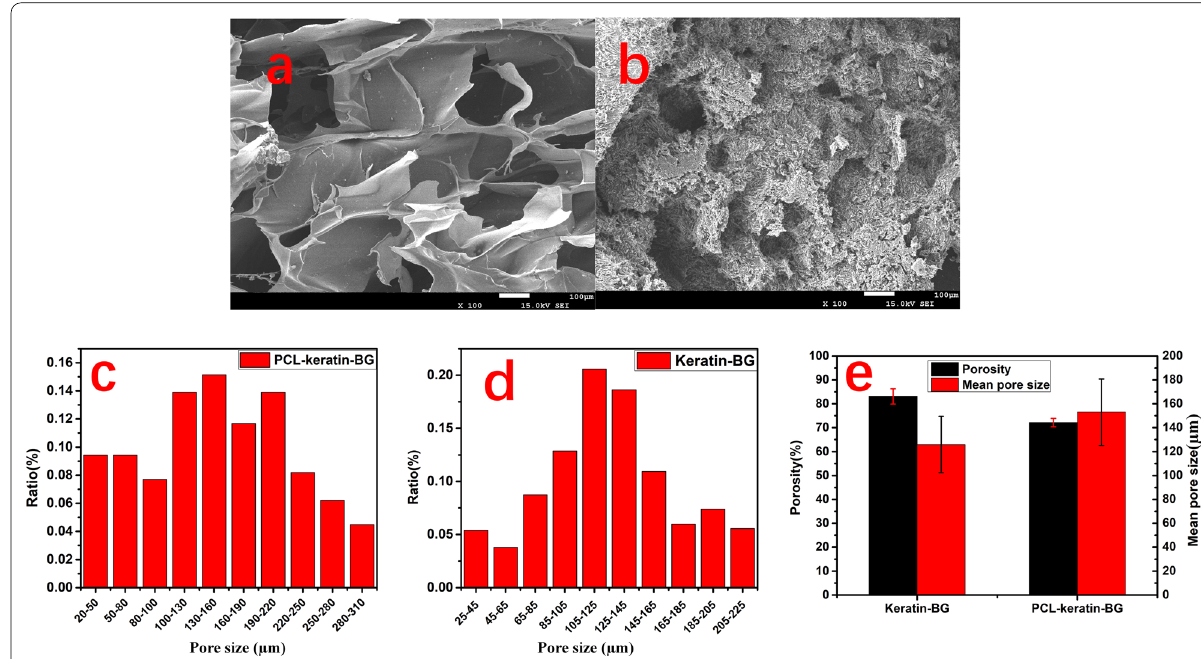
Fig. 4 SEM images and pore size distribution of ( a , c ) keratin-BG and ( b , d ) PCL-keratin BG, respectively, ( e ) porosity and mean pore size of keratin-BG and PCL-keratin-BG